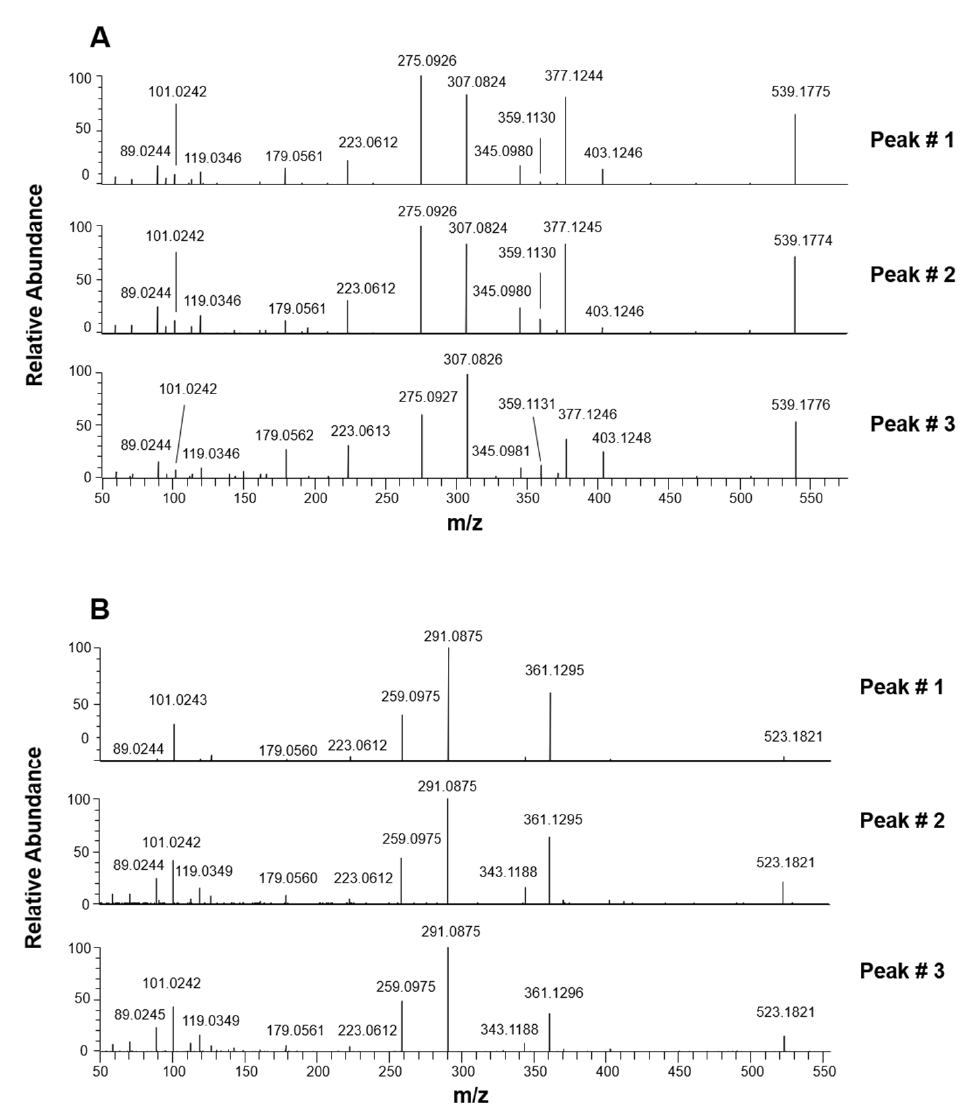
Figure 3. HCD-MS/MS spectra averaged under peaks detected in the XIC traces referred to oleu- ropein/oleuroside ( A ) and to ligstroside and its positional isomers ( B ) after the RPLC-ESI(-)-FTMS analyses of Coratina leaves extracts.